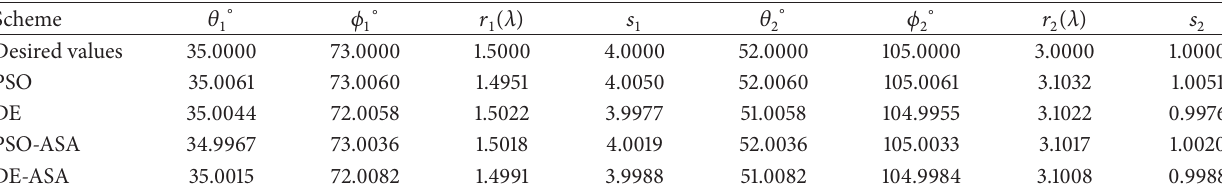
Table 2: Estimation accuracy for 2 targets.